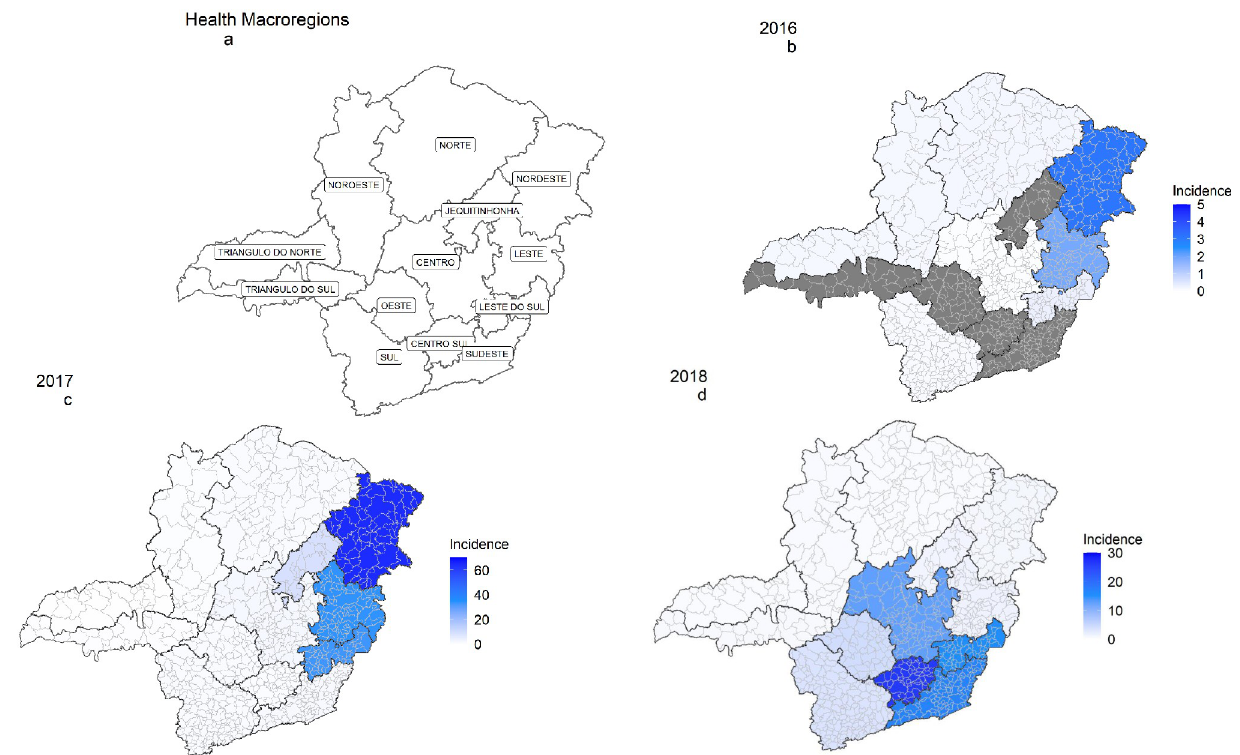
Fig 2. Yellow fever incidence per 100 thousand inhabitants according to major health region and year of onset of symptoms, Minas Gerais, Brazil, 2016 to 2018. Fig (a) Minas Gerais state map according to macroregions; (b) Incidence of yellow fever per 100,000 inhabitants in 2016, (c) Incidence of